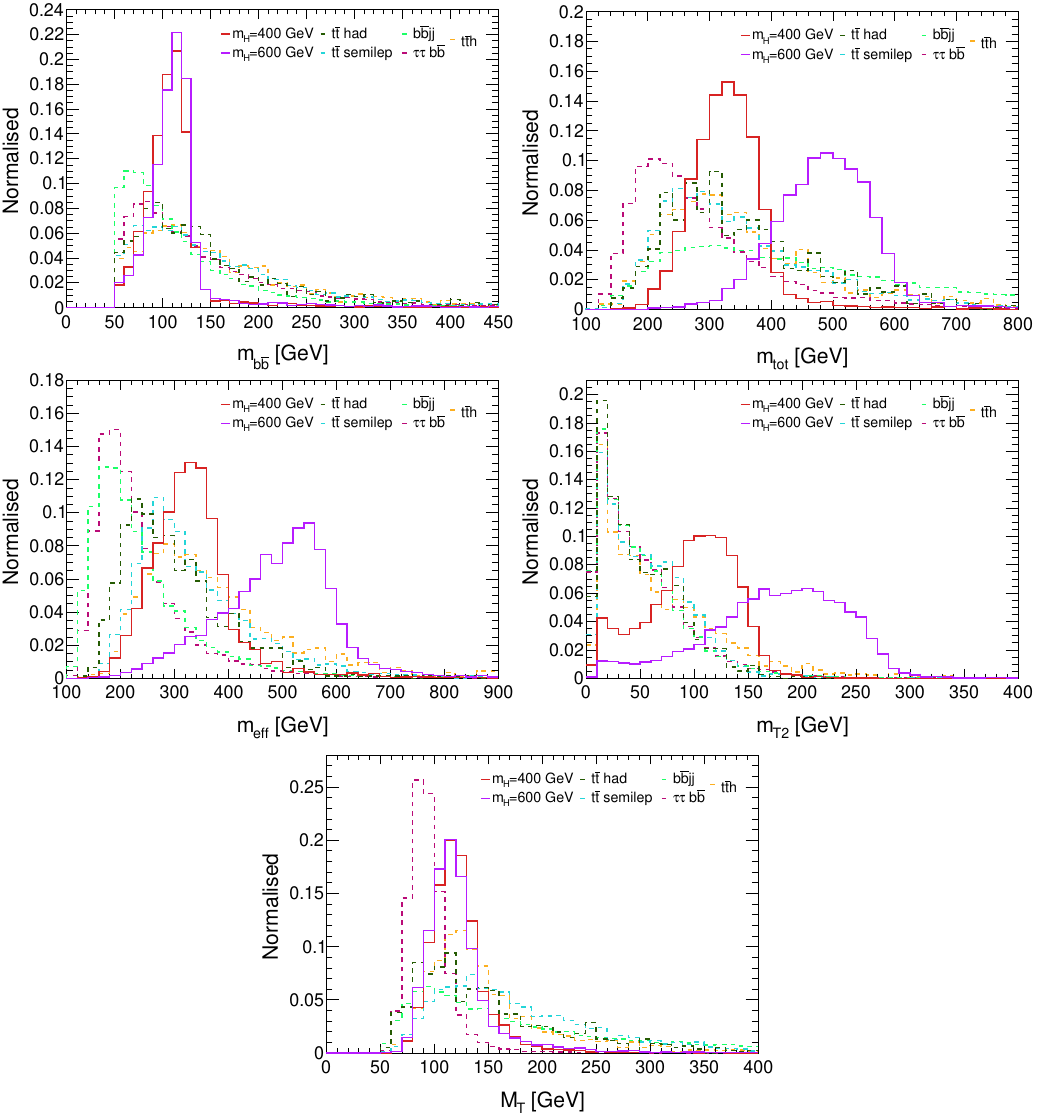
Figure 15 . The m bb , m tot , m e(cid:11) , m T 2 and M T distributions for heavy Higgs masses of m H = 400 and 600 GeV with dominant backgrounds. Here the heavy Higgs boson is searched for in the b (cid:22) b(cid:28) h (cid:28) h (cid:12)nal state. The distributions are shown after imposing the basic trigger